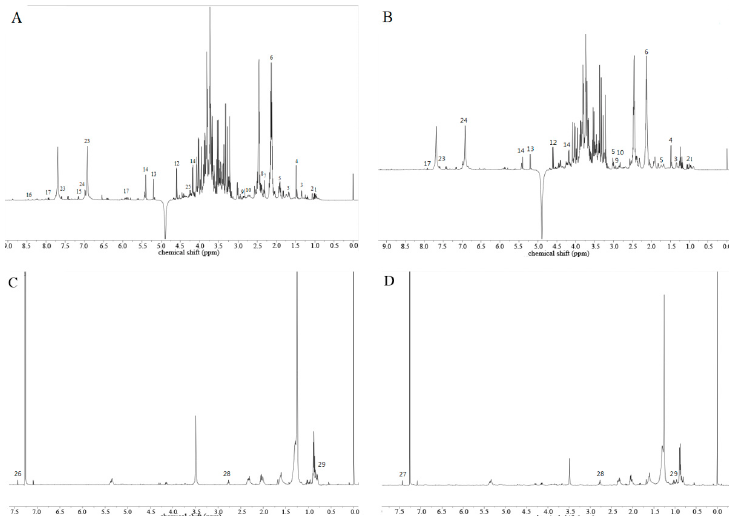
Figure 5. Spectra of 1 H-NMR of the adventitious root treated with 100 µ mol · L − 1 MeJA at the 16th day of subculture. ( A ) Methanol aqueous phase of control. ( B ) Methanol aqueous phase of treatment. ( C ) Chloroform phase of control. ( D ) Chloroform phase of treatment. The compounds represented by numbers were listed in Table